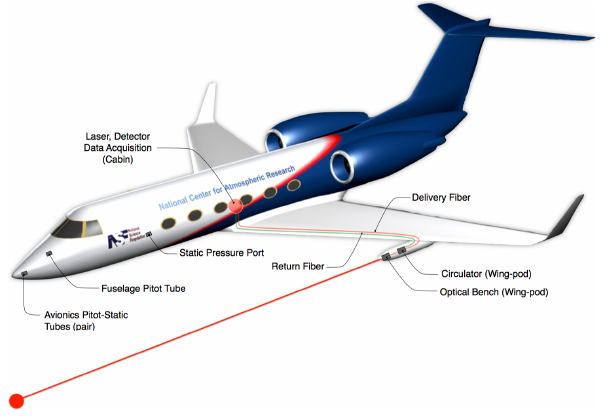
Figure 1. Diagram of the LAMS. Light generated by the laser in the cabin is transmitted by optical fibres to a wing pod, where it is transmitted in a beam that has a focal point well ahead of the aircraft (farther ahead than suggested by this not-to-scale diagram). The light backscattered from aerosol particles in the focal region is collected by the lens, and a circulator mixes a portion of the trans- mitted signal with the returned signal. The resulting signal, with interference patterns that measure the Doppler shift of the backscat- tered light, is returned via optical fibre to the cabin for digitization. Also illustrated in this figure are the approximate locations of the static pressure ports and the fuselage pitot tube used by the research data system to measure static and dynamic pressures. This figure appears in Applied Optics in the article by Spuler et al. (2011) and is used here with permission from the Optical Society of